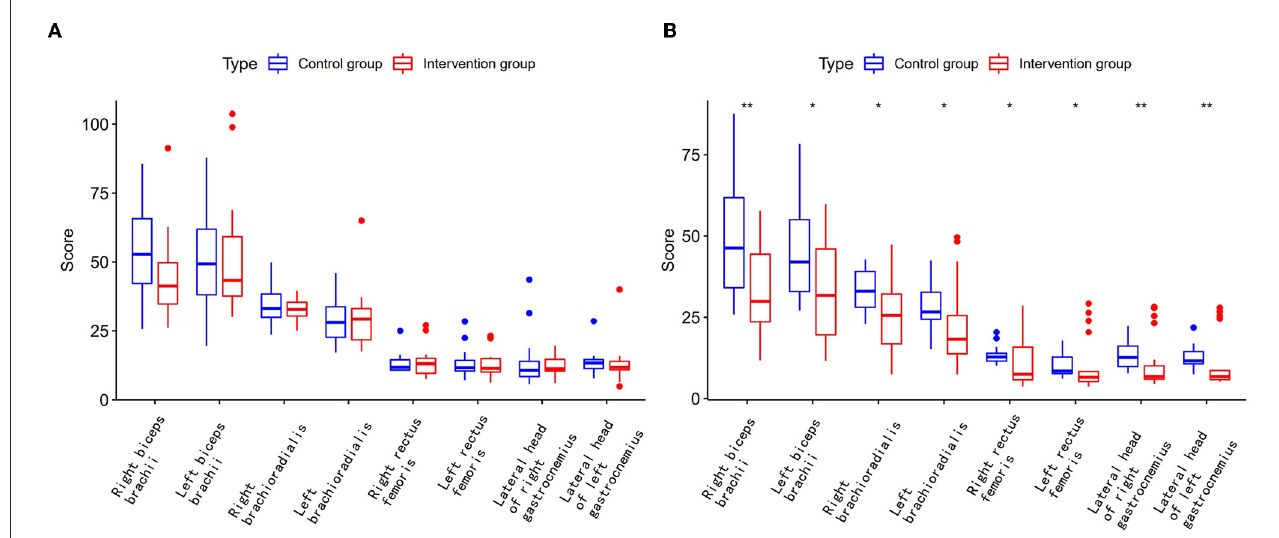
FIGURE3 Real-time shear wave elastography score of PD patients. Intervention group: QHN group. Control group: SA group. (A) The SWE score before treatment between two groups. (B) The SWE score after treatment between two groups.